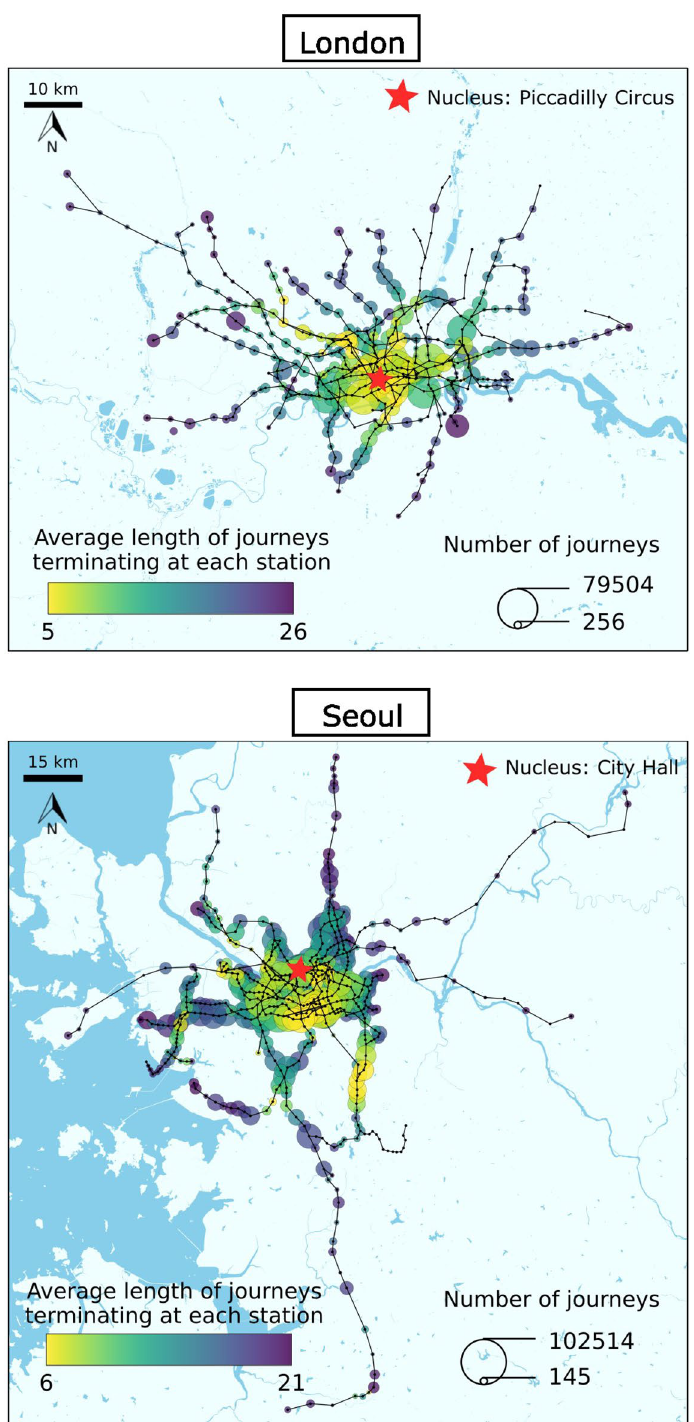
Figure 1. Map of London’s and Seoul’s public transport systems. The figure has been produced using Python and Inkscape, based on the data sets described in “Data and notation” and geographic data from OpenS treet Map for the basemap